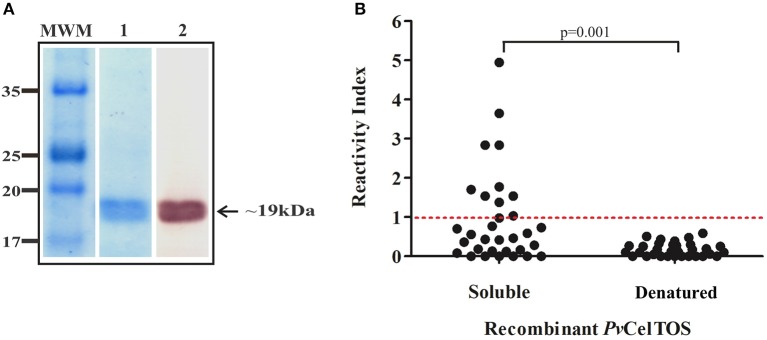
Soluble recombinant PvCelTOS was recognized by P. vivax infected individuals' sera. Full-length recombinant PvCelTOS protein was obtained in E. coli as a soluble protein and purified by affinity chromatography. A band of about 19 kDa was observed by Coomassie staining (1) and Western blot (2). MWM, molecular weight marker (A). Soluble rPvCelTOS was recognized by sera from P. vivax-infected individuals. The figure shows specific IgG Ab reactivity indices. The red line represents the cutoff reactivity index (RI) considered for classifying individuals as positive (>1) or negative (<1) for PvCelTOS (B). Analysis was carried out in triplicate. The Mann-Whitney test was used for comparing both groups.